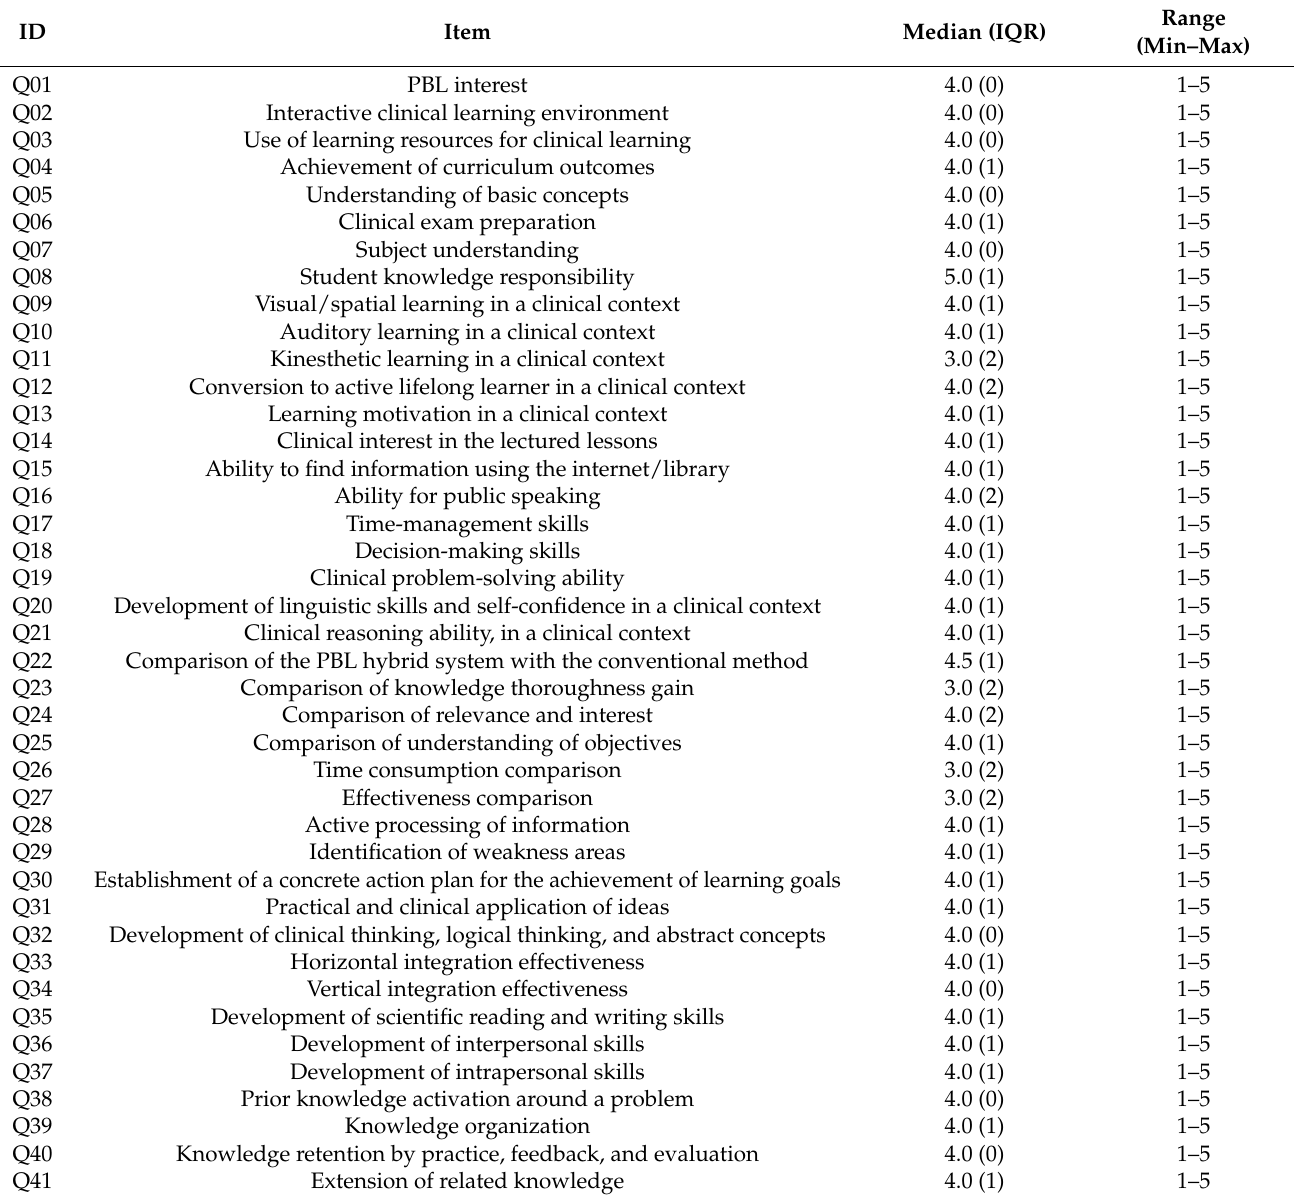
Table 3. Questionnaire answers (n = 118). For each question, the correspondent median, interquartile range (IQR), minimum, and maximum values are